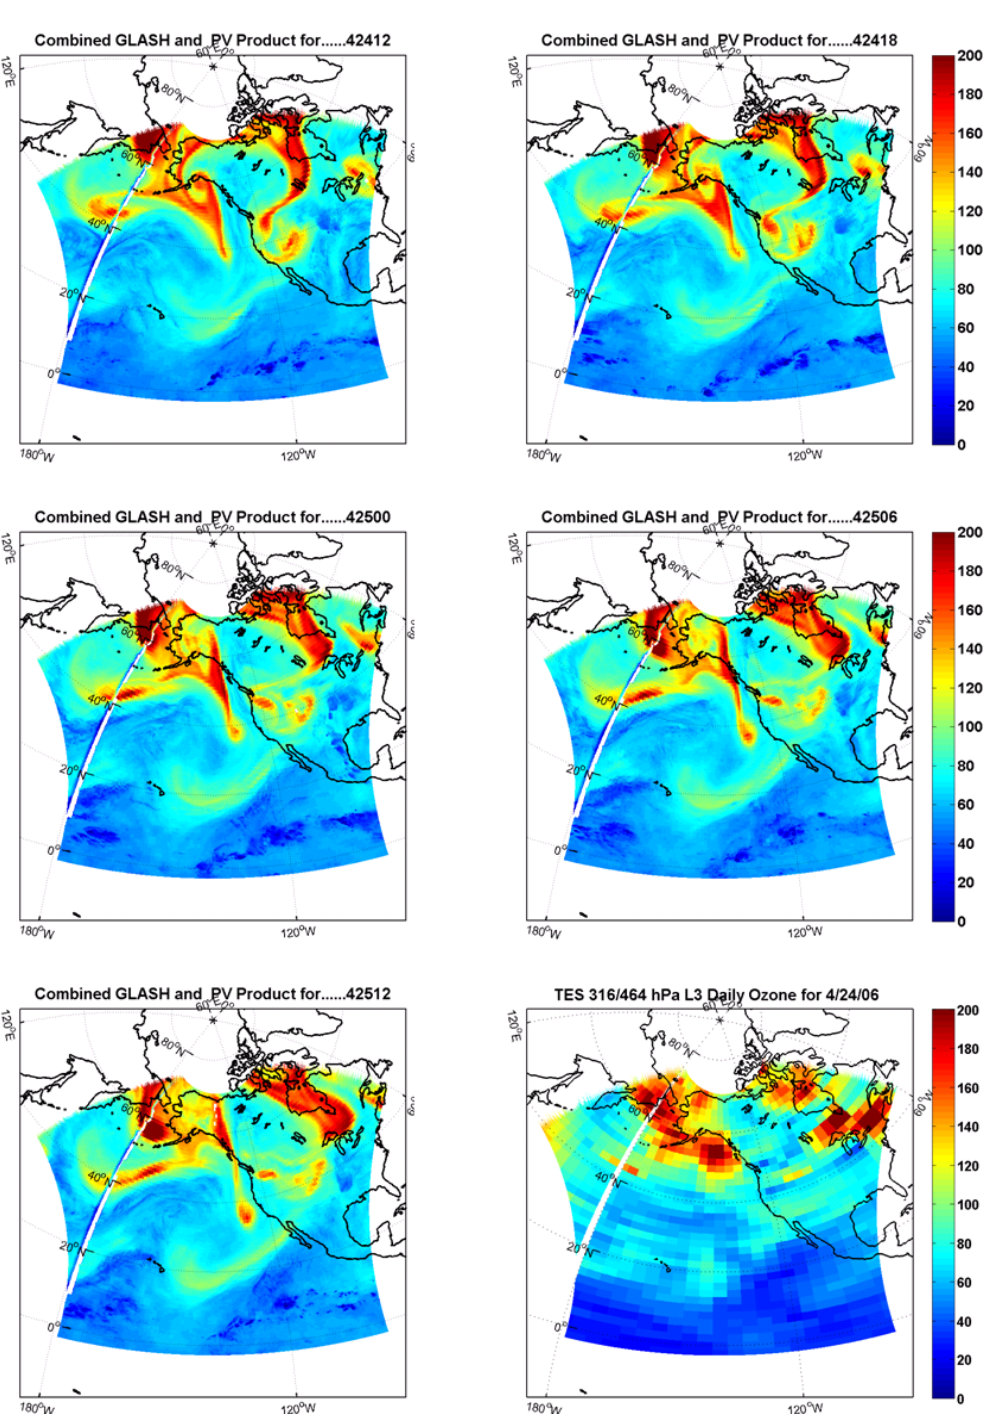
Fig. 7. Plot of 5 (first 5 panes) MUTOP products from the at 6h intervals from 24 April at 12:00UTC to 25 April at 12:00UTC. These images correspond to the time over which TES global survey overpass measurements were used to create the TES Level 3 Daily Ozone plot (bottom right pane) through spatial interpolation. This daily ozone plot is an average of the 316 and 464hPa daily plots for that day (to better match the UT ozone plots). Ozone mixing ratio is plotted in color in all panes in